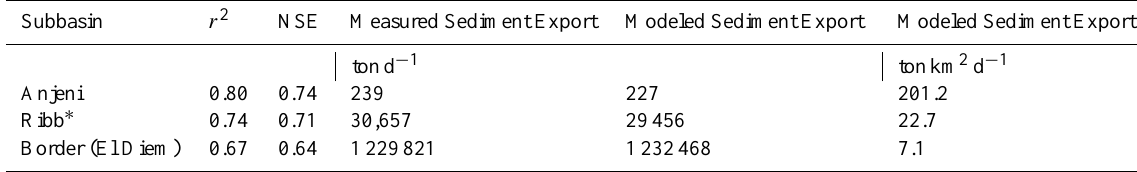
Table 4. Model fit statistics (coefficient of determination, r 2 and Nash-Sutcliffe Efficiency, NSE), and sediment export for the Anjeni, Ribb, and Border (El Diem) Subbasins during the rainy season.